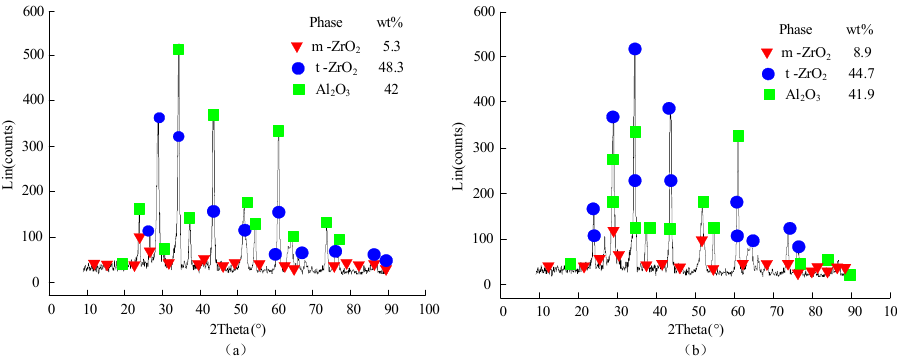
Figure 15. Results of XRD diffraction. ( a ) A = 0 μ m ( b ) A = 12.5 μ m.